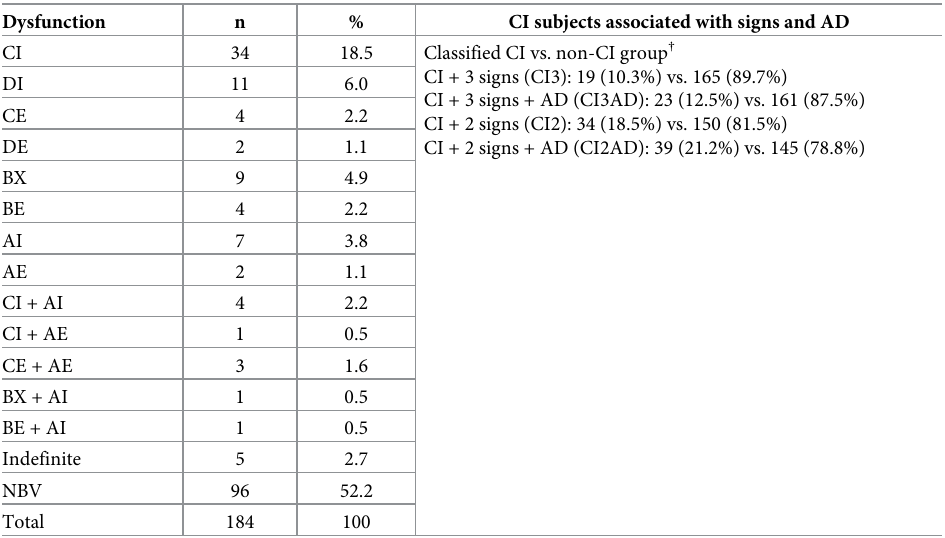
Table 3. Prevalence of binocular vision anomalies.